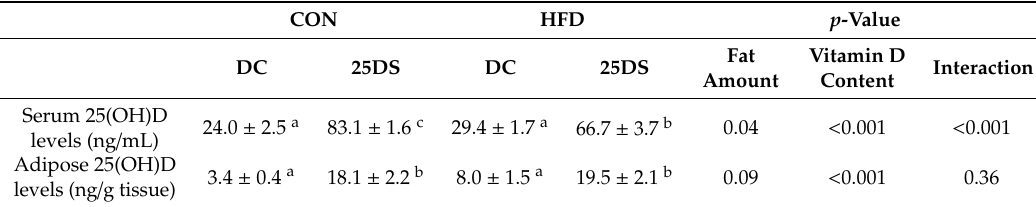
Table 5. Serum and epididymal adipose tissue 25(OH)D levels 1,2